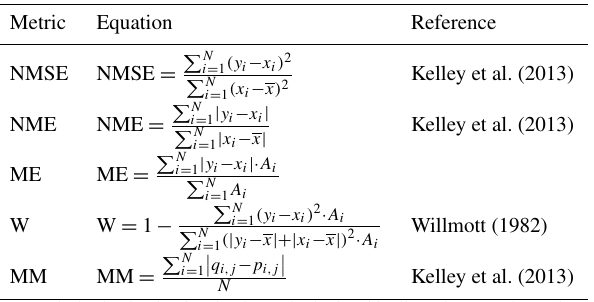
Table 1. Evaluation metrics used in this